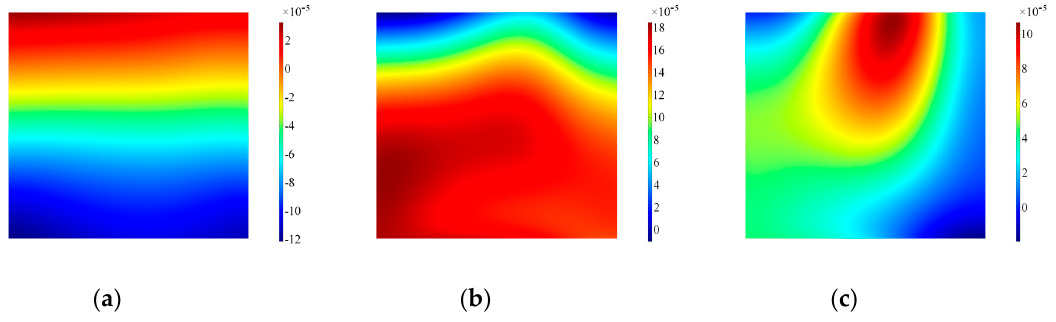
Figure 18. Surface plot for the in-plane velocity on the side of the backing mass, Configuration A’. Note that data are plotted at timeframes of 100 μ s ( a ), 300 μ s ( b ) and 500 μ s ( c ).